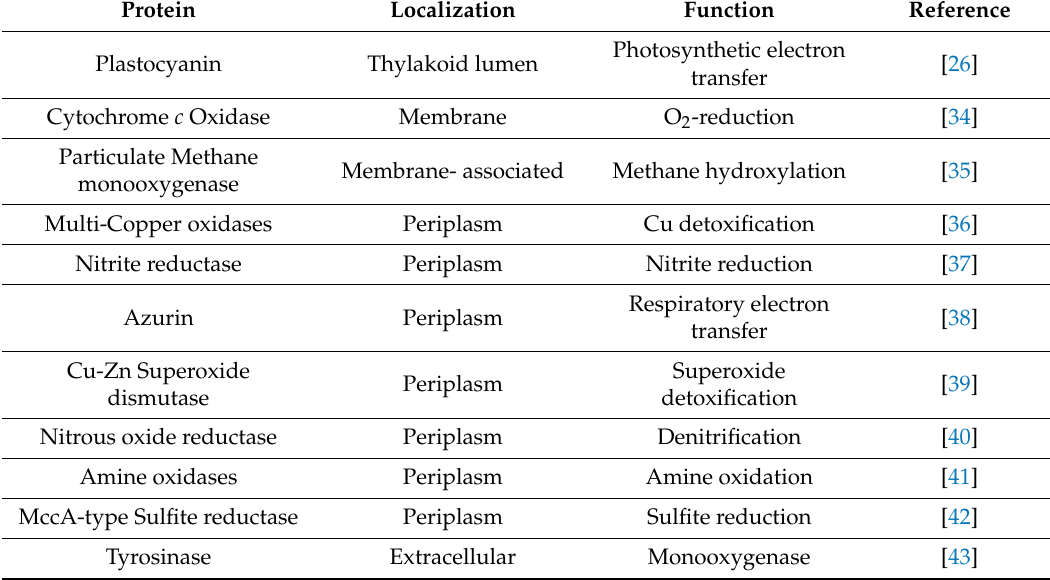
Table 1. Examples of bacterial cuproenzymes. Listed are cuproenzymes that stably bind copper in their catalytic center. Cuproproteins, which only transiently bind copper, such as Cu-chaperones, Cu-binding proteins or Cu-responsive transcriptional regulators, are described in the main